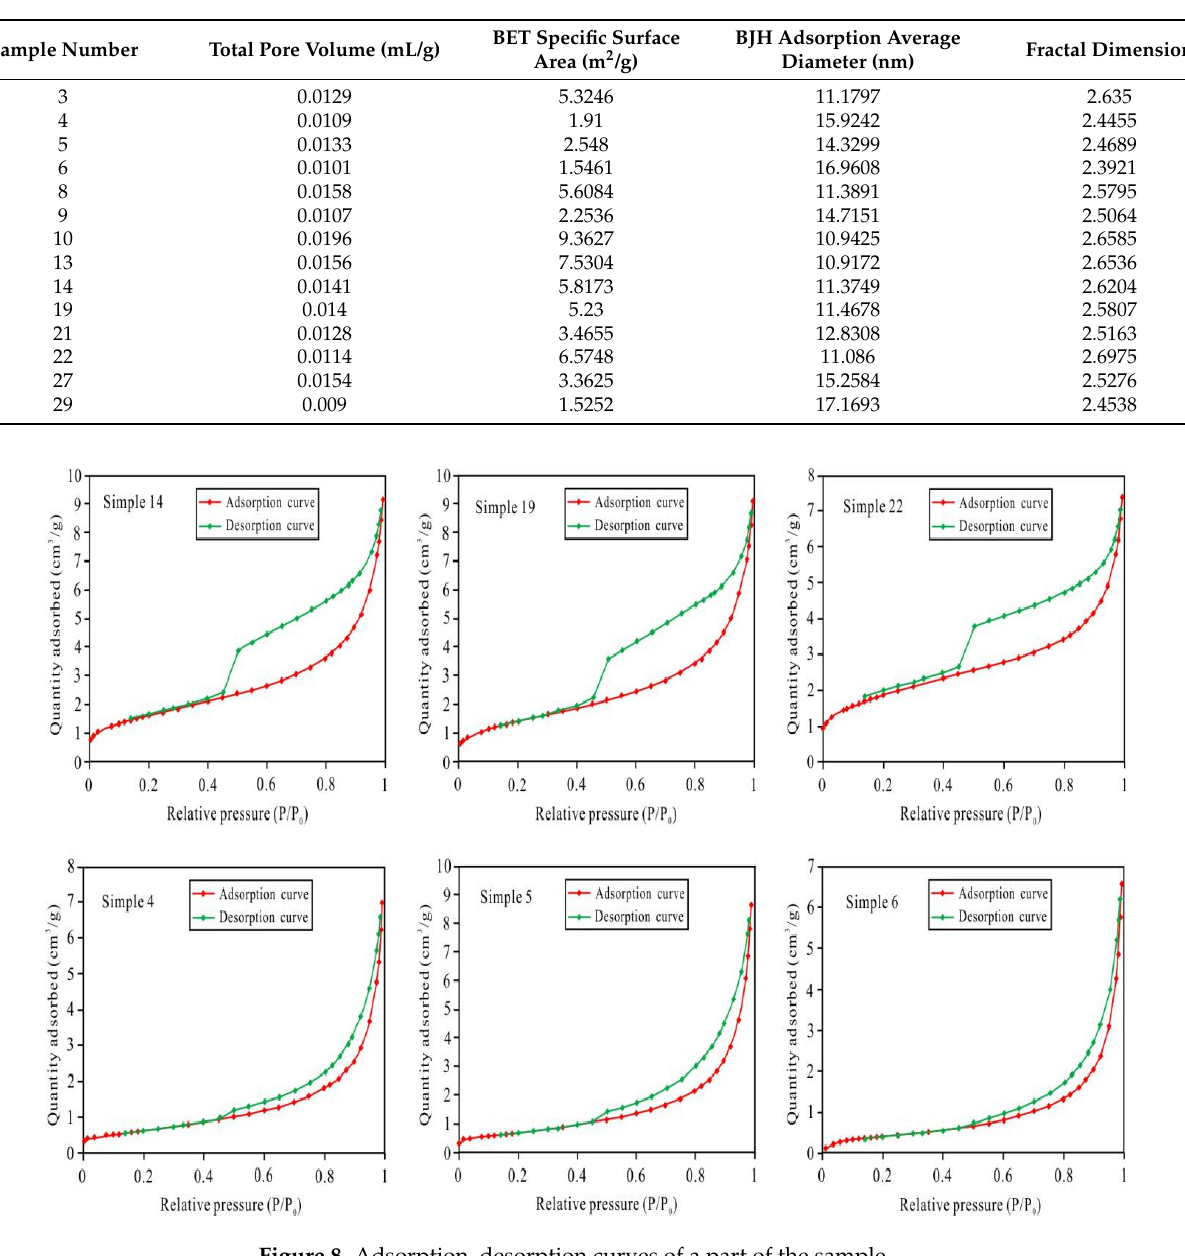
Table 3. Parameters for microscopic pore structures drawn from the LTNA.